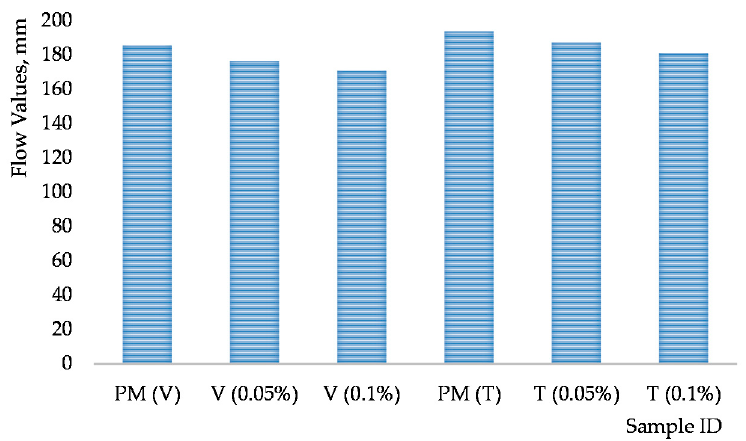
Figure 8. Flow values of cementitious composites .